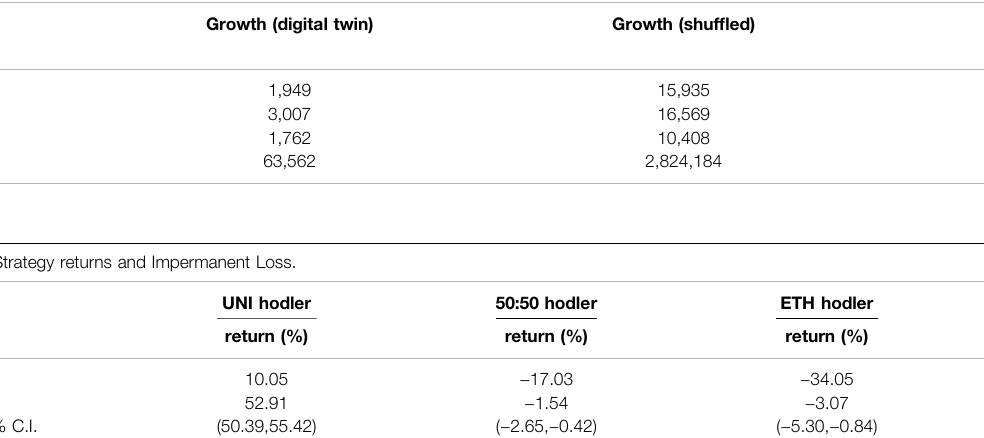
TABLE 4 | Token balance and invariance growth.